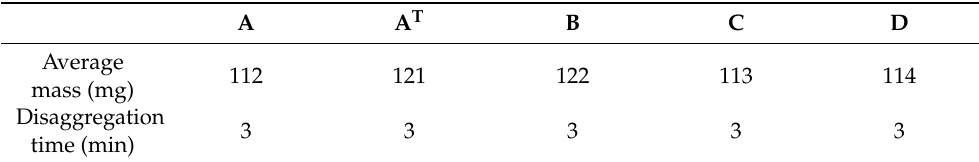
Table 10. Disintegration time on three oral form samples produced by A, A T , B, C and D